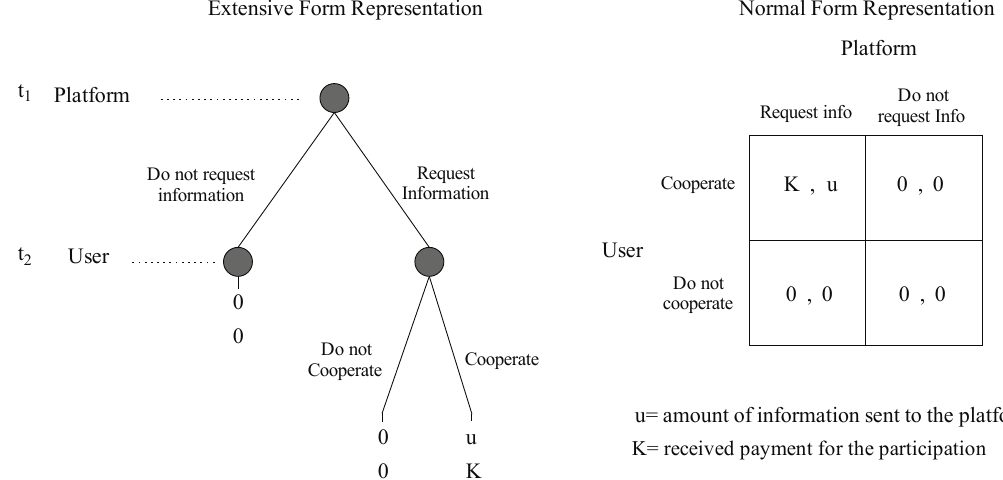
Figure 4. Game theoretic representation of our problem in normal and extensive form.